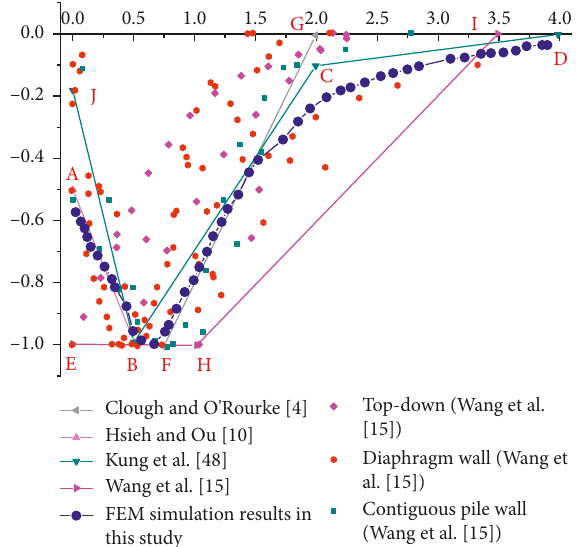
Figure 8: Relationship between ground settlement normalized by maximum settlement and normalized distance from